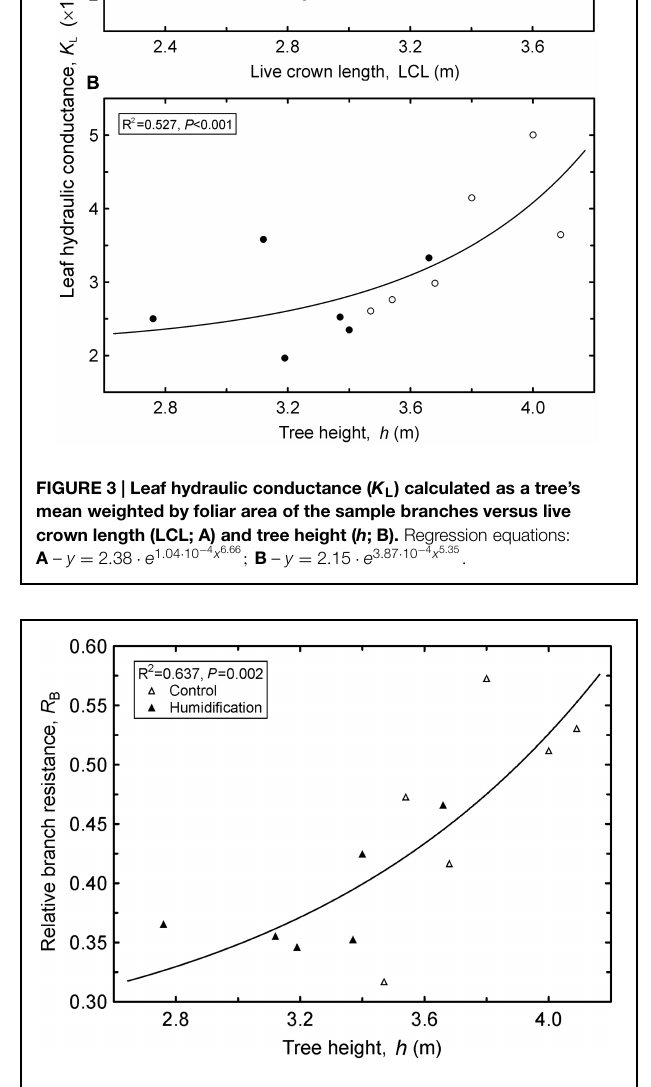
acclimation to enhance the leaf functional efficiency